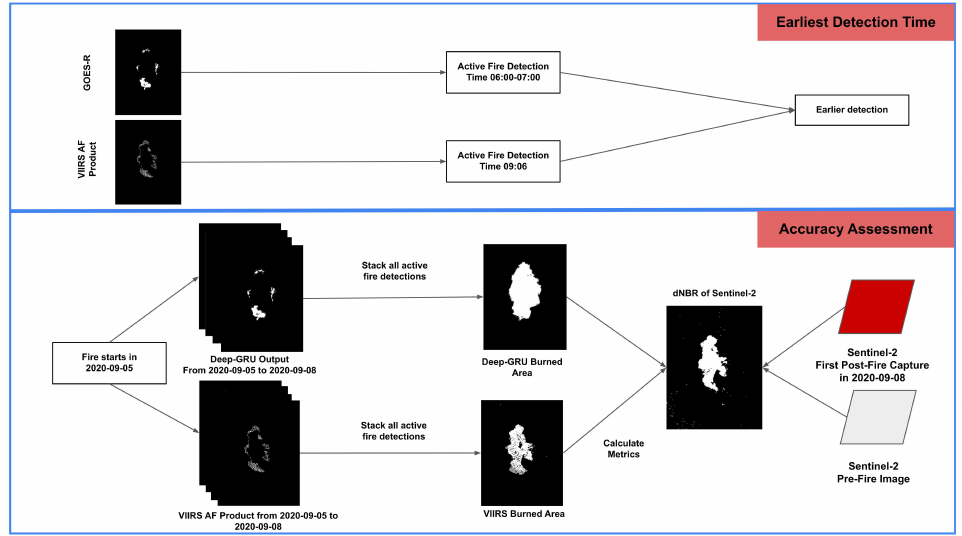
Figure 11. Evaluation Diagrams for Earliest Detection Time and Burned Area Accuracy